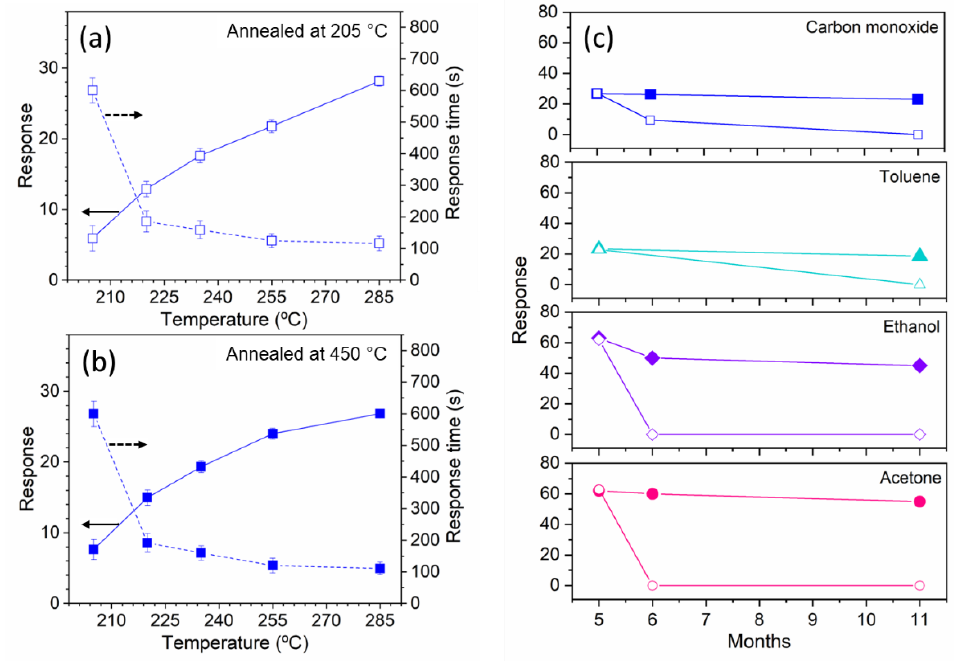
Figure 5. Temperature dependence of the response and response time of the copper oxide nanowires annealed at, ( a ) 205 °C and ( b ) 450 °C to 80 ppm of carbon monoxide during the first test period, and ( c ) replicates of the response to 80 ppm of various gases during six months (operating temperature: 285 °C). The zero value in ( c ) represents the impossibility to obtain a measure due to the early damage of the sensor. Empty and filled symbols stand for the annealed samples at 205 and 450 °C, respectively.